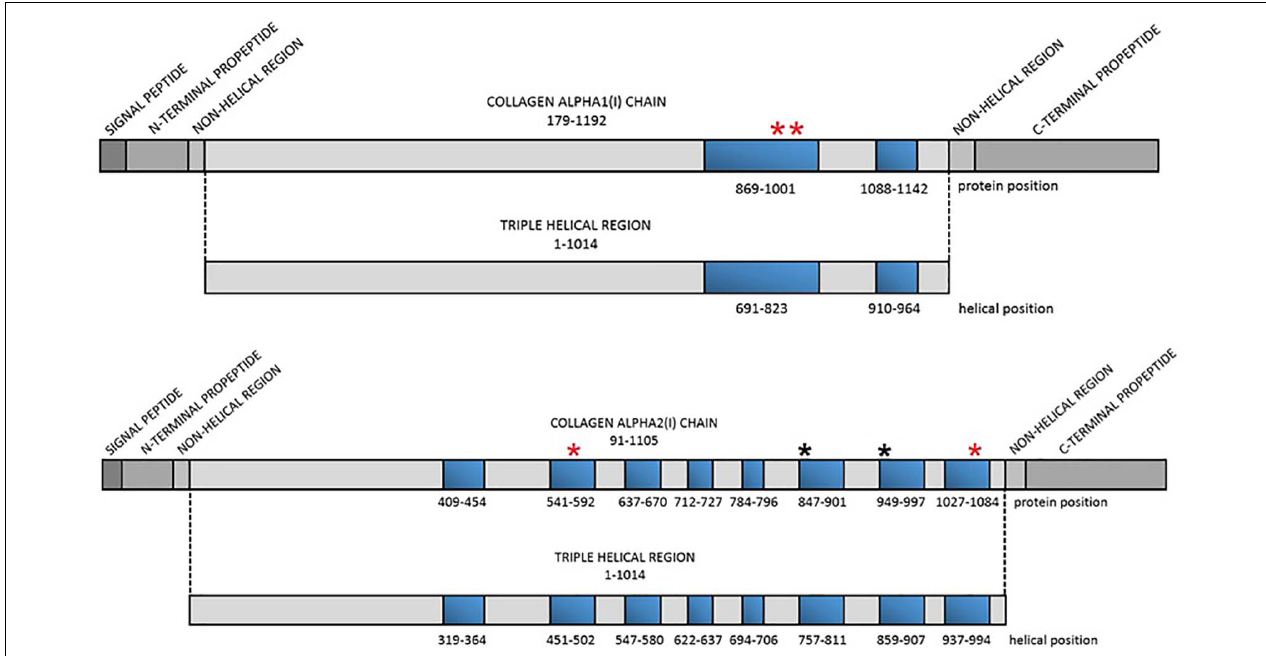
FIGURE 1 | Localization of the lethal regions of collagen type I genes and the identified variants. Red asterisk refers to localization of the novel variants, black asterisk refers to localization of variants reported previously. Blue bars represent particular lethal regions. The numbering of the regions corresponds to protein and helical position in each alpha(I)